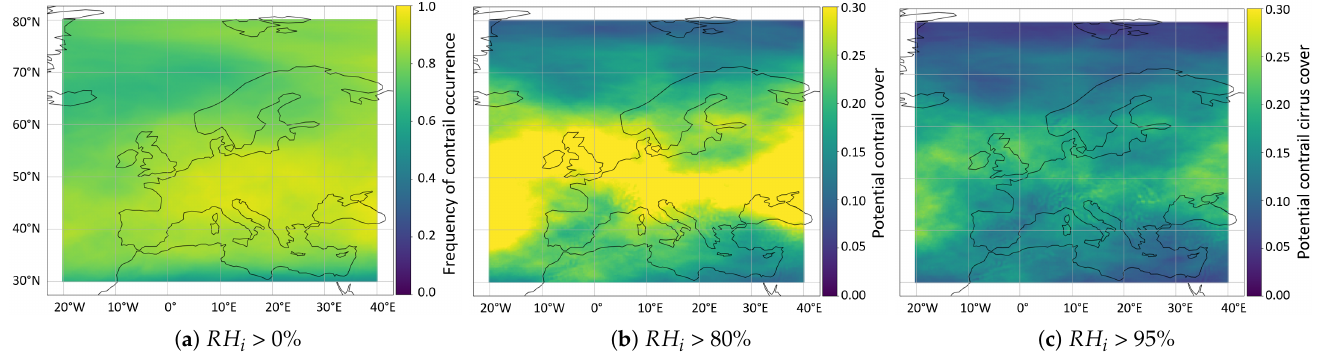
Figure 3. Influence of the different thresholds for the relative humidity over ice on contrail formation and persistence. ( a ) The frequency of contrail occurrence with no threshold for the relative humidity, ( b ) the potential contrail cover (>80% RH i ), and ( c ) the potential contrail cirrus cover (>95% RH i ) is mapped over Europe at pressure level 250hPa for the first half of April. Note the different color scales for ( a ) compared to ( b , c